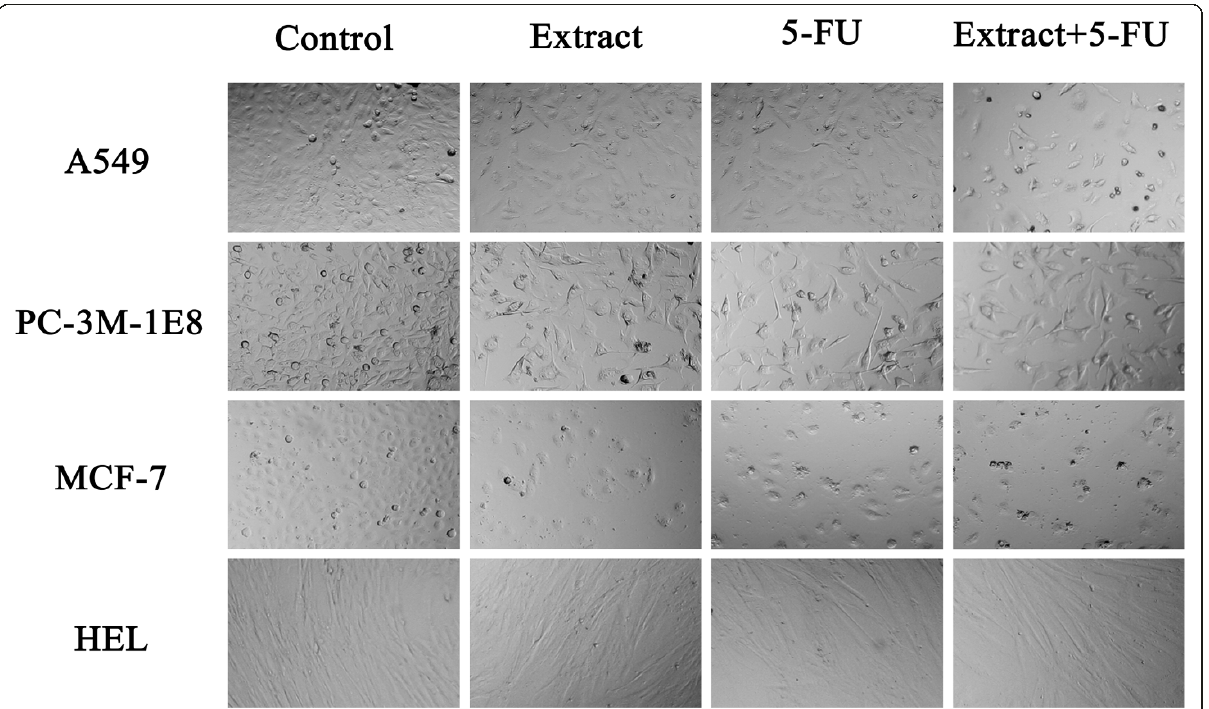
Figure 7 Cytotoxicity in cancerous and normal human cell lines . A549, PC-3M-1E8, MCF-7 and HELwere treated with 10 μ g/ml TC extract, 5-